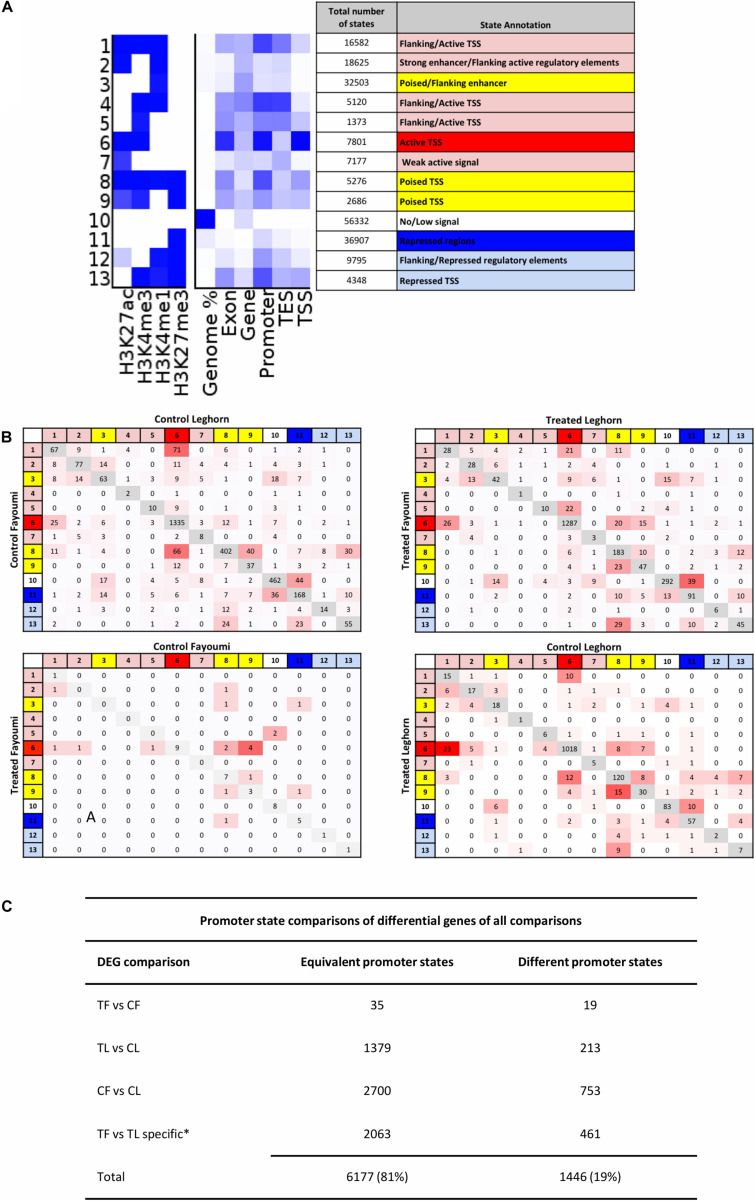
The promoter states of differentially expressed genes generally are not different between groups, suggesting enhancers may play a role in modulating expression for these DEGs. (A) Annotation of chromatin states are based on promoter enrichment, gene expression correlation, and known associations of histone modifications to regulatory elements and their activity. States are grouped into three main activity groups: active (red), poised (yellow), and repressed (blue). (B) Promoter transition tables are shown for the DEGs in each comparison. (C) Table summarizing the states that remain the same between two groups or are different between groups is shown in (A) and includes the total number of promoters that were the same and were different between two groups. *Numbers shown for TF versus TL comparison refer to DEGs specific to that gene set in comparison to the CF vs. CL gene set. CF, control Fayoumi; TF, treated Fayoumi; CL, control Leghorn; TL, treated Leghorn.